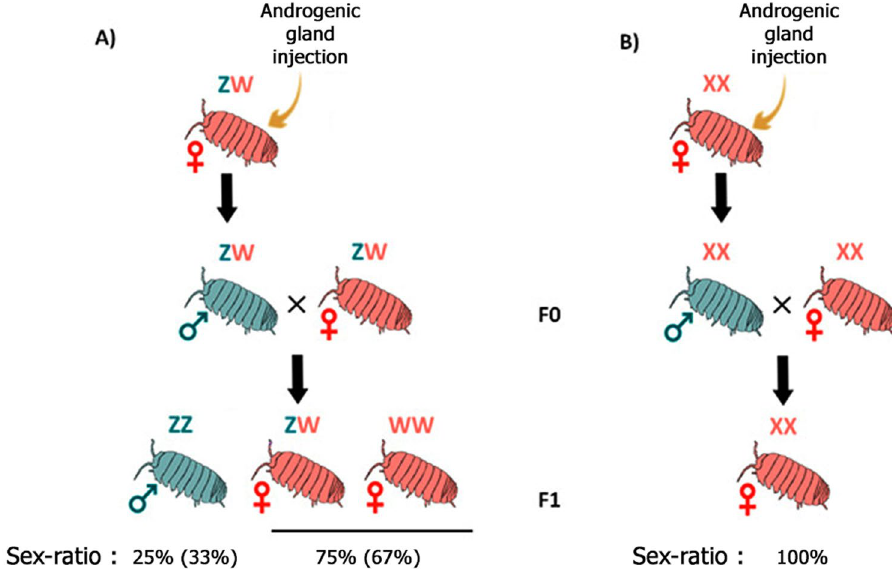
Figure 1. Principle of crossing experiments between neo-males (i.e. sex-reversed females) and genetic females. ( A ) Female heterogametic system (ZZ/ZW). The expected sex-ratio of the progeny of a neo-male and a genetic female is 25% males (ZZ) and 75% females (ZW and WW) if the WW genotype is viable, or 33% males (ZZ) and 67% females (ZW only) if the WW genotype is not viable. ( B ) Male heterogametic system (XX/XY). The expected sex-ratio of the progeny of a neo-male and a genetic female is 100% females (XX).